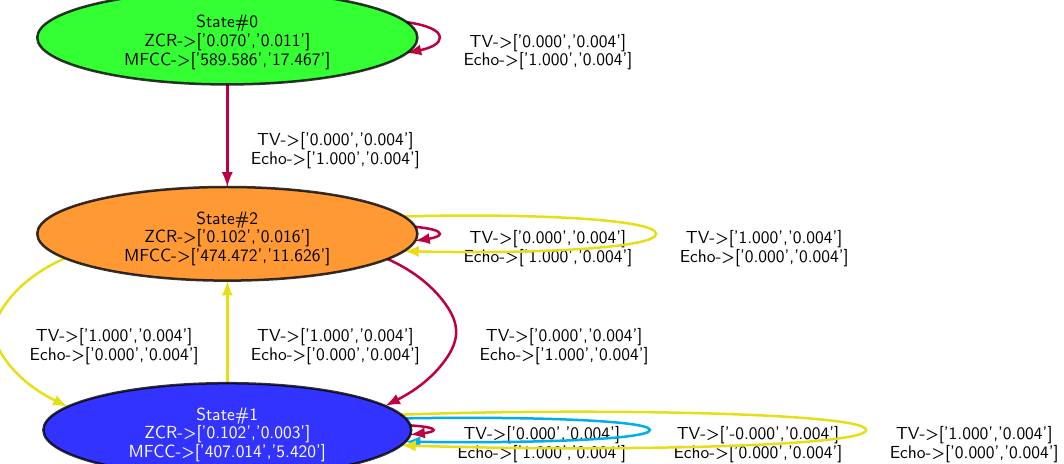
Figure 7. IOHMM model of the legitimate behavior learned from the input/output observations depicted in Figure 6 applied to Algorithm 1 ( min_samples =